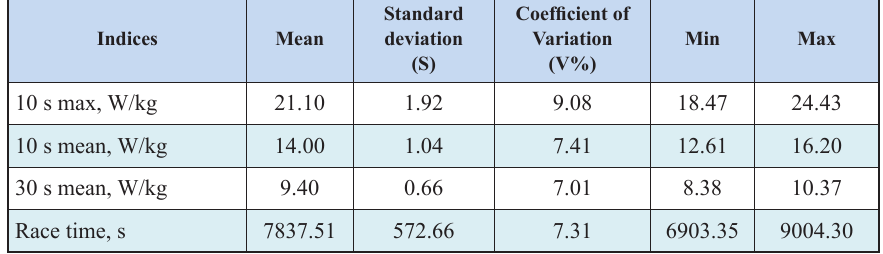
Table 2. Relative anaerobic power output and race time